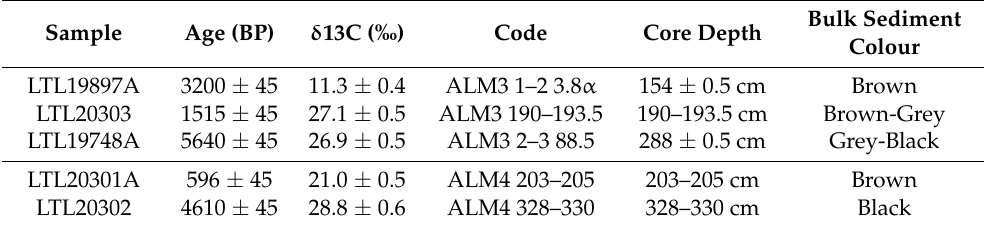
Table 1. Absolute ages of dated